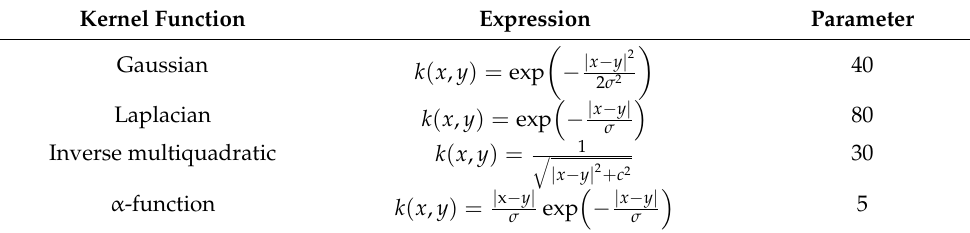
Table 2. Different kernel functions for STIP calculation.